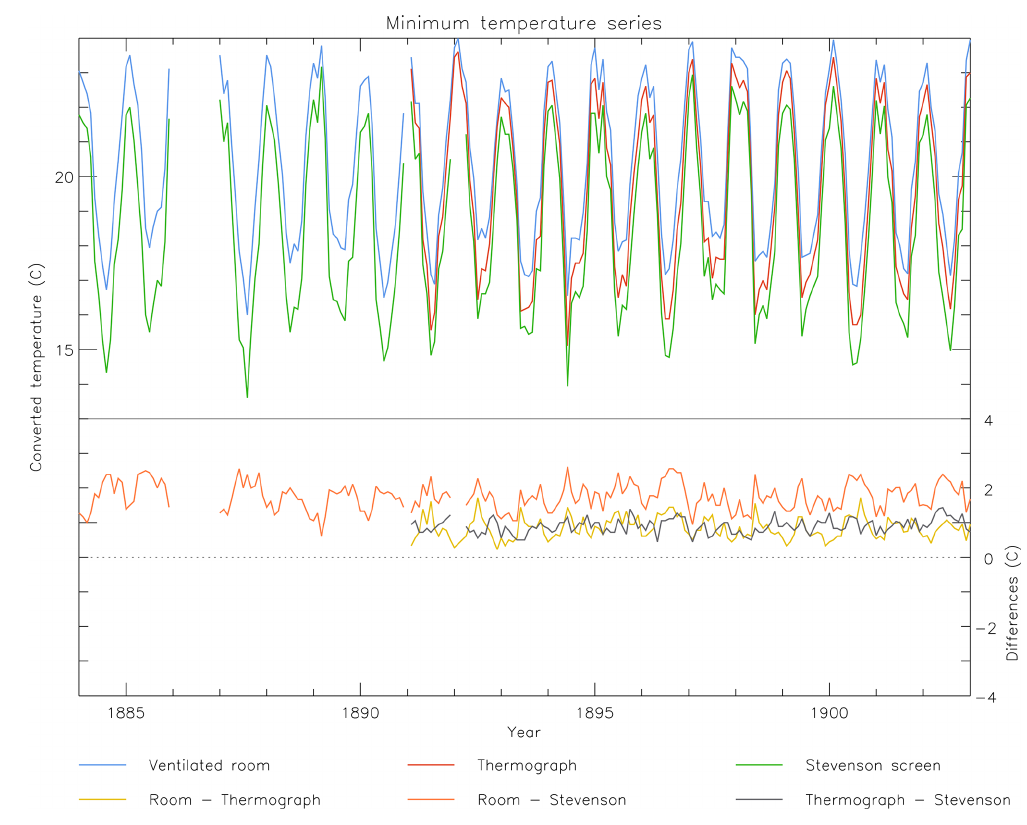
Figure 13. As Fig. 11, but for minimum